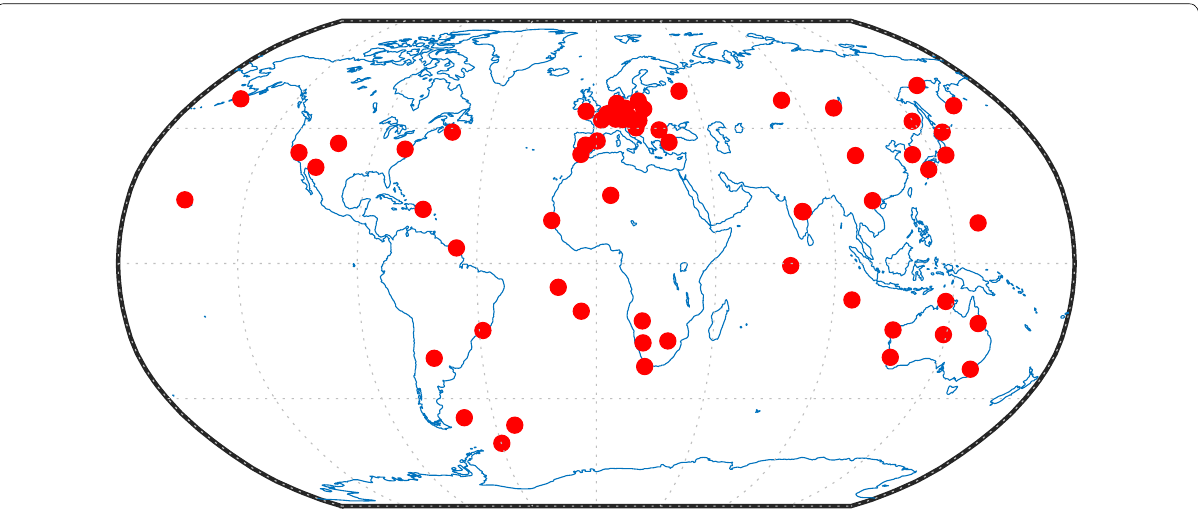
Fig. 2 Observatories used in the model